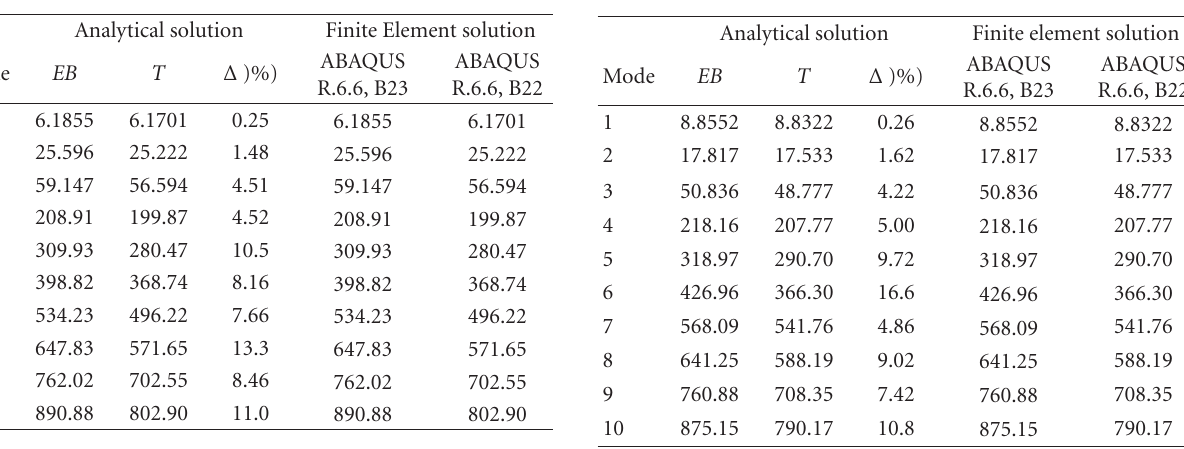
Table 11: First ten natural frequencies (Hz); see Table 7; θ 2,3 = − 90 ◦ , − 90 ◦